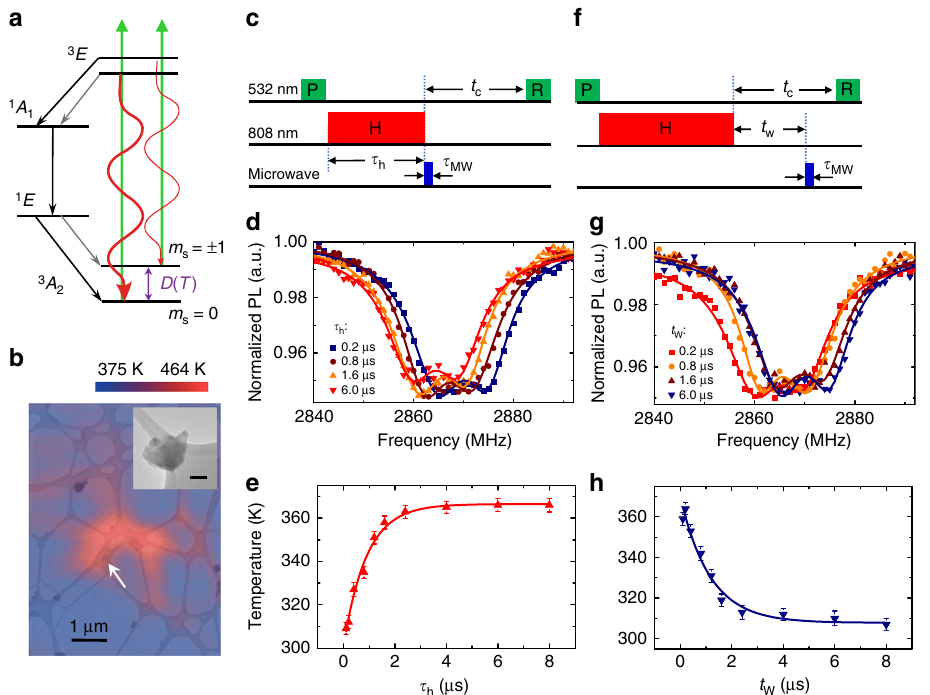
Fig. 1 Fast temperature control of a nanodiamond (ND) by pulse NIR laser heating. a The energy level diagram of a nitrogen-vacancy (NV) center illustrating the spin polarization and readout. b Transmission electron microscopy (TEM) image of amorphous carbon fi lm with NDs. The color contour shows the temperature of an ND (indicated by the arrow) as a function of the position of the NIR laser focus spot. The temperature is extracted from the zero- fi eld splitting (ZFS) D of the NV centers in the ND using the known D-T relation in ref. 15 . Inset: a typical TEM image of an ND on a carbon fi lm (scale bar: 50 nm). c Pulse sequence for characterizing the heating dynamics, including the 532 nm laser pulses for spin polarization (P) and readout (R), the 808 nm laser pulse for heating (H), and the microwave pulse for spin control. d Optically detected magnetic resonance (ODMR) spectra of an ND for various heating durations (for the pulse sequence in c ). The cooling time t c = 10 μ s is fi xed. e The ND temperature as a function of the heating pulse duration τ h , extracted from the ZFS D obtained from the ODMR spectra in ( d ) using the D-T relation in ref. 15 . f Pulse sequence for characterizing the cooling dynamics. The symbols are the same as in ( c ). g ODMR spectra of an ND for various waiting durations t w , with a fi xed heating duration τ h = 10 μ s, and a fi xed cooling time t c = 10 μ s (for the pulse sequence in f ). h The cooling dynamics: the temperature of the ND as a function of the waiting period t w . Error bars in ( e )